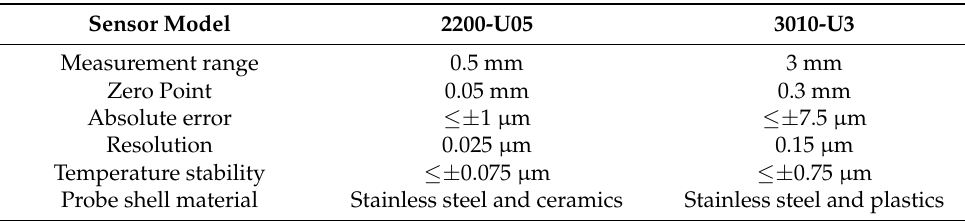
Figure 4. The eddy ‐ current sensors used in the test. Figure 4. The eddy-current sensors used in the test. Table 2. Sensor